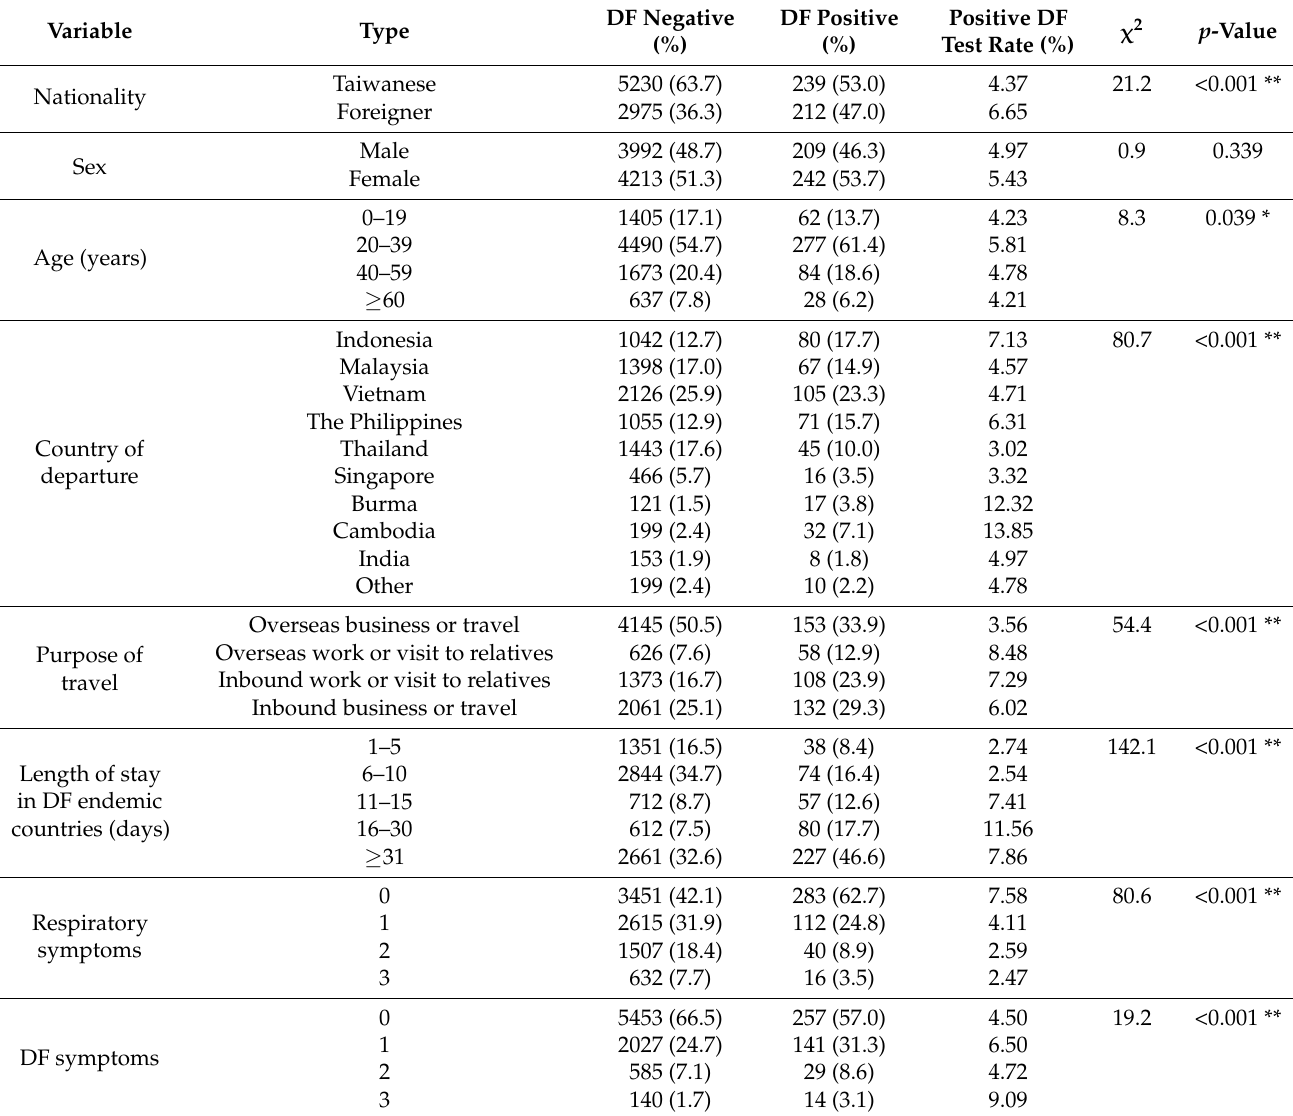
Table 1. Demographic information and positive test rates of passengers with DF at international airports in Taiwan ( n =